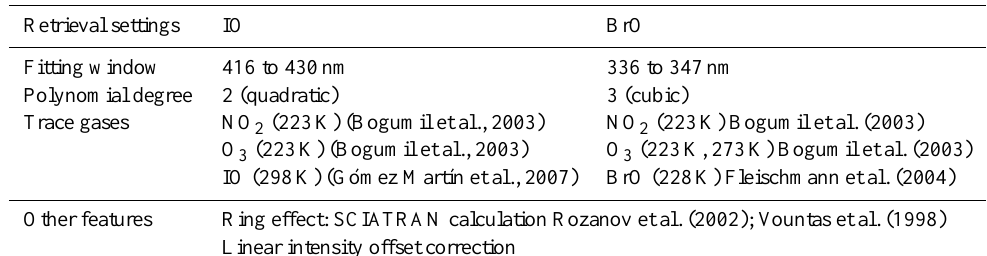
Table 1. Settings for the DOAS retrieval of IO and BrO in this study. For the trace gases taken into account, the temperatures of the respective cross sections are given in